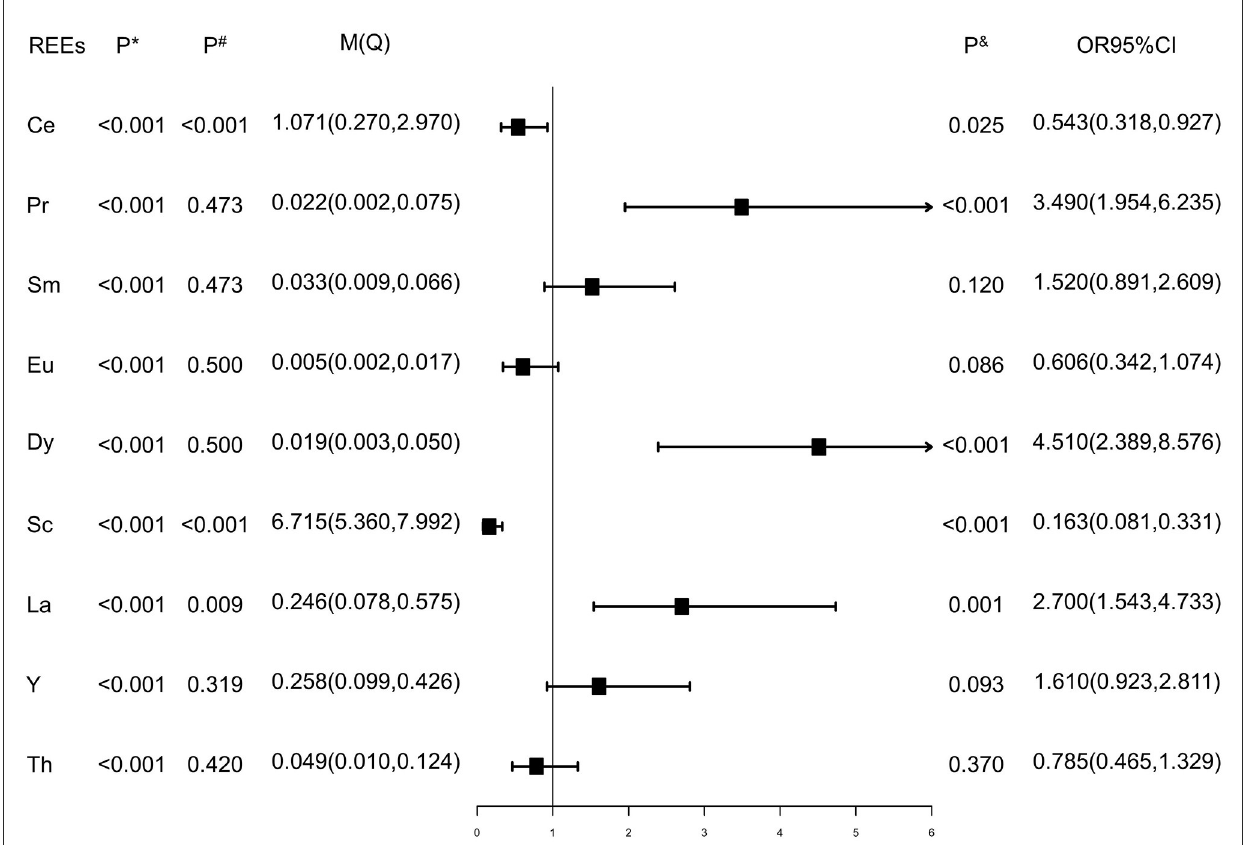
FIGURE1 Rare earth elements of enrolled subjects. P*: P values of Shapiro-Wilk test. P # : P values of Wilcoxon rank sum test. P & : P values of logistic regression adjusted age, gender, residence, family history of cancers, BMI, tobacco smoking, tea, and alcohol drinking. M(Q): Median (quartile25, quartile75), µ